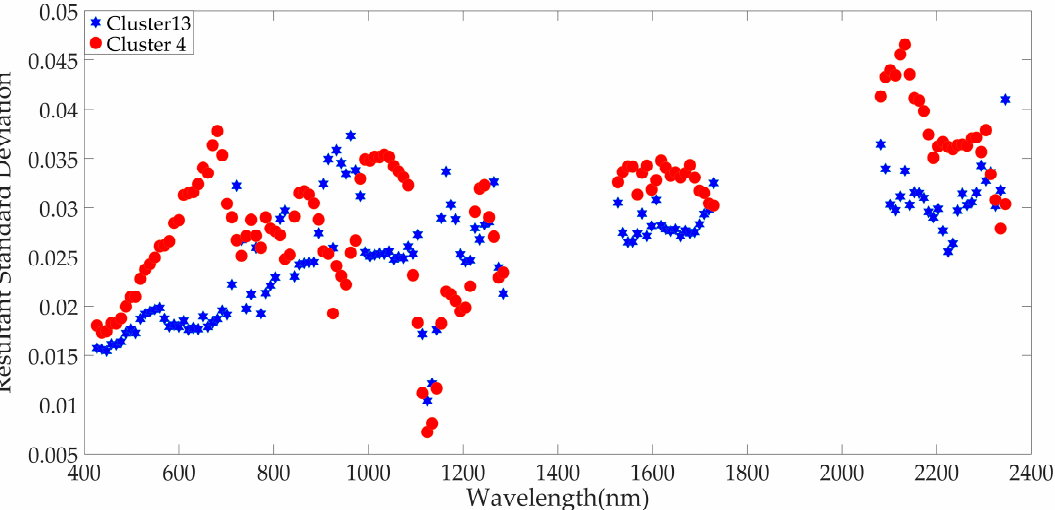
Figure 23. Comparison of resultant standard deviation (1 sigma) of clusters 13 and 4. The blue and red symbols represent the resultant standard deviation of clusters 13 and 4.